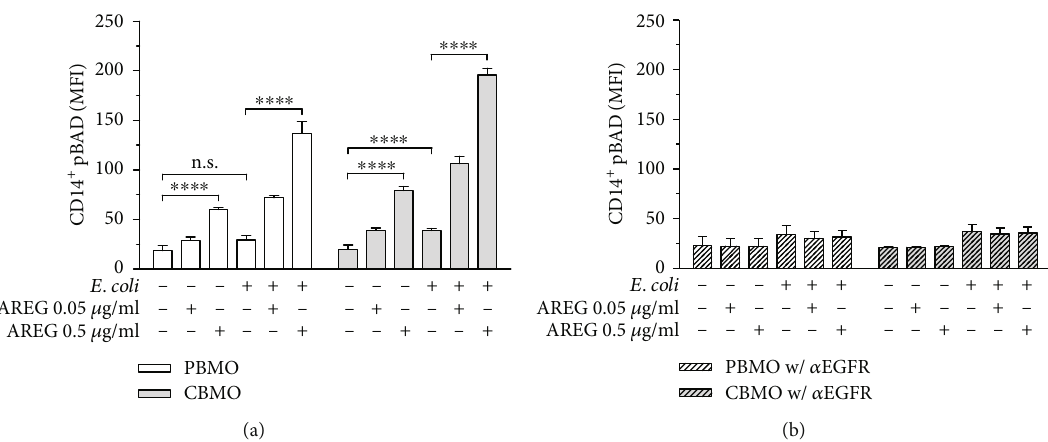
Figure 2: pBAD intracellular protein levels in PBMO and CMBO in response to infection, AREG stimulation, and inhibition of EGFR. Isolated monocytes were infected with E. coli , extracellular bacteria were removed, and the cells were cultivated for 24 h in medium supplemented with antibiotics. 1h prior to infection, AREG stimulation and EGFR inhibitor treatment were started and maintained during the entire cultivation period. Quanti fi cation was performed by using fl ow cytometry. (a) pBAD in PBMO and CBMO in response to infection and AREG stimulation. E. coli infection leads to BAD phosphorylation. Increase in pBAD is dose-dependently induced by AREG in both control and E. coli -infected PBMO and CBMO ( n = 5 ). (b) E ff ect of EGFR inhibition on pBAD in PBMO and CBMO in response to infection and AREG stimulation. Inhibition of EGFR abolishes both AREG- and infection-induced increase in pBAD levels ( n = 4 ). Data are shown as means + SD . Statistical signi fi cance was analyzed by using two-way ANOVA with Bonferroni ’ s